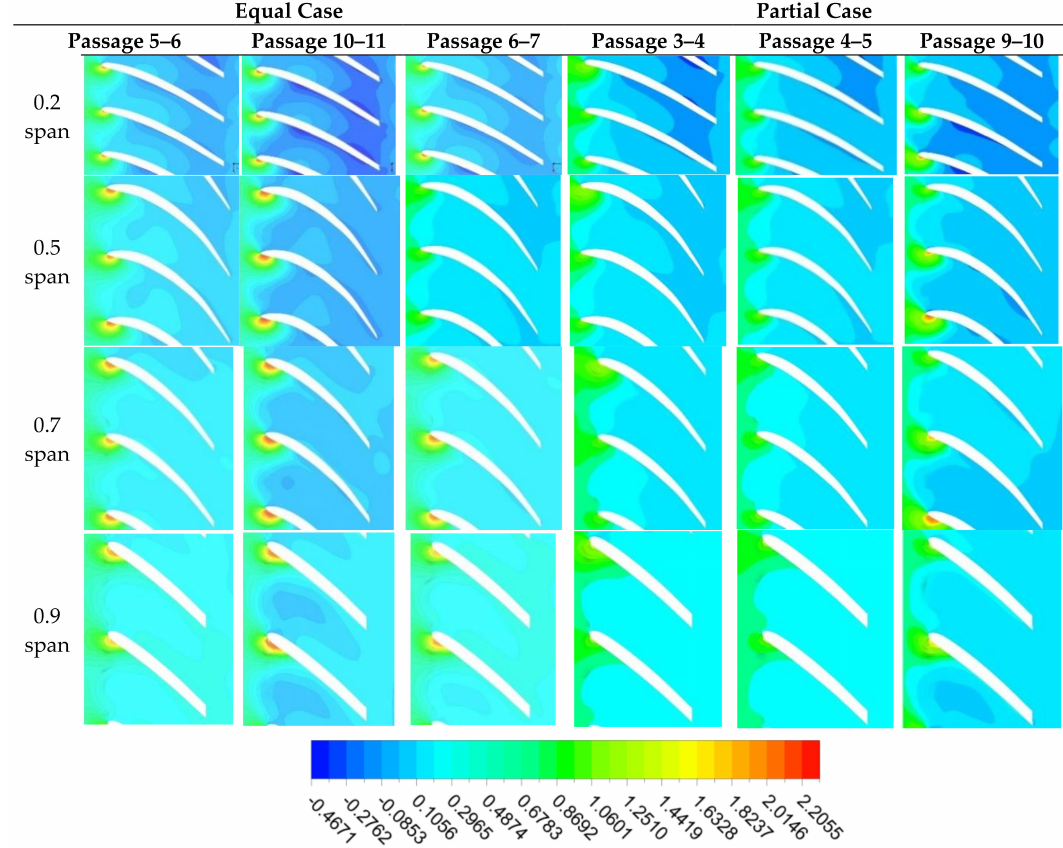
Figure 10. Total pressure loss coefficient contours in various span heights in blade passages 5–6,